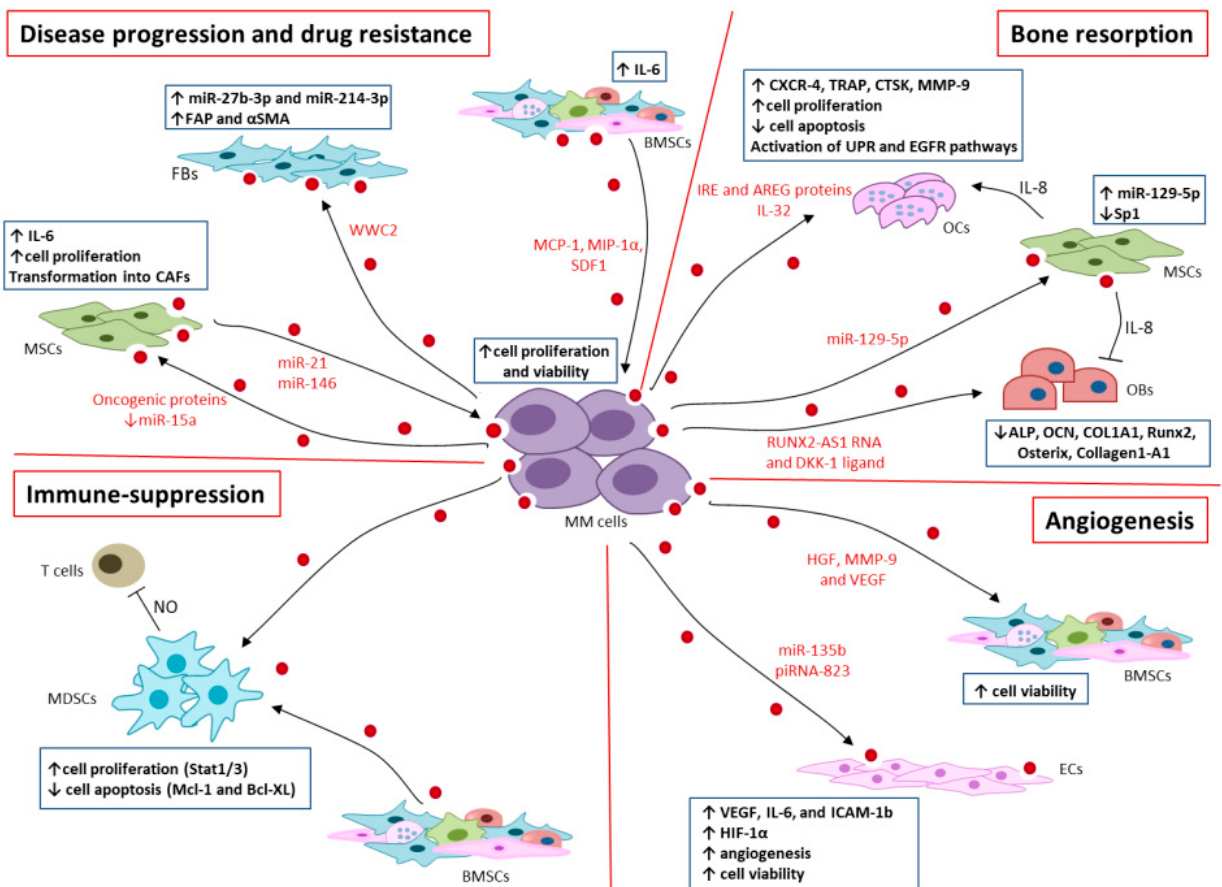
Figure 2. Schematic representation EVs-mediated interaction in BM microenvironment. MM cells release EVs that contain oncogenic proteins, cytokines, miRs, and other ncRNAs that support: (i) disease progression and drug resistance supporting fibroblast (FBs) activation, conversion of mesenchymal stromal cells (MSCs) into cancer-associated fibroblasts (CAFs) and IL-6 release by bone marrow stromal cells (BMSCs); (ii) bone resorption by increasing proliferation and function of osteoclasts (OCs) and preventing their apoptosis, and by inhibiting osteoblast differentiation; (iii) angiogenesis through the release of pro-angiogenic cytokines and chemokines, which promote the viability of endothelial cells (ECs) and BMSCs and the release of pro-angiogenic factors; and (iv) immunosuppression, which promotes the expansion of myeloid derived suppressor cells (MDSCs) and the production of the immunosuppressive adenosine (ADO). Finally, EVs from BMSCs, in turn, promote the proliferation and viability of MM cells, thus supporting disease progression and drug